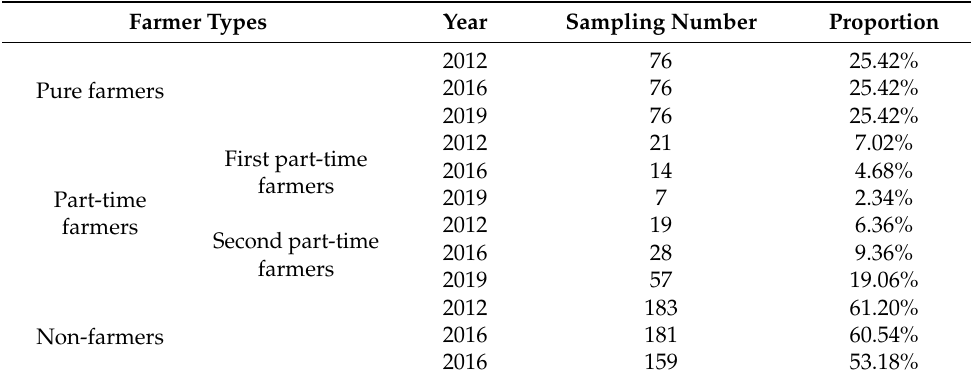
Table 2. Farmer types and sample distribution in each